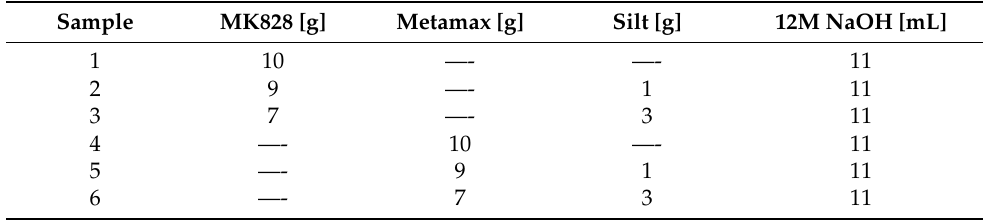
Table 2. Composition of the geopolymer sample in terms of metakaolin (Masterlife MK828 and Metamax), waste silt, and 12M NaOH